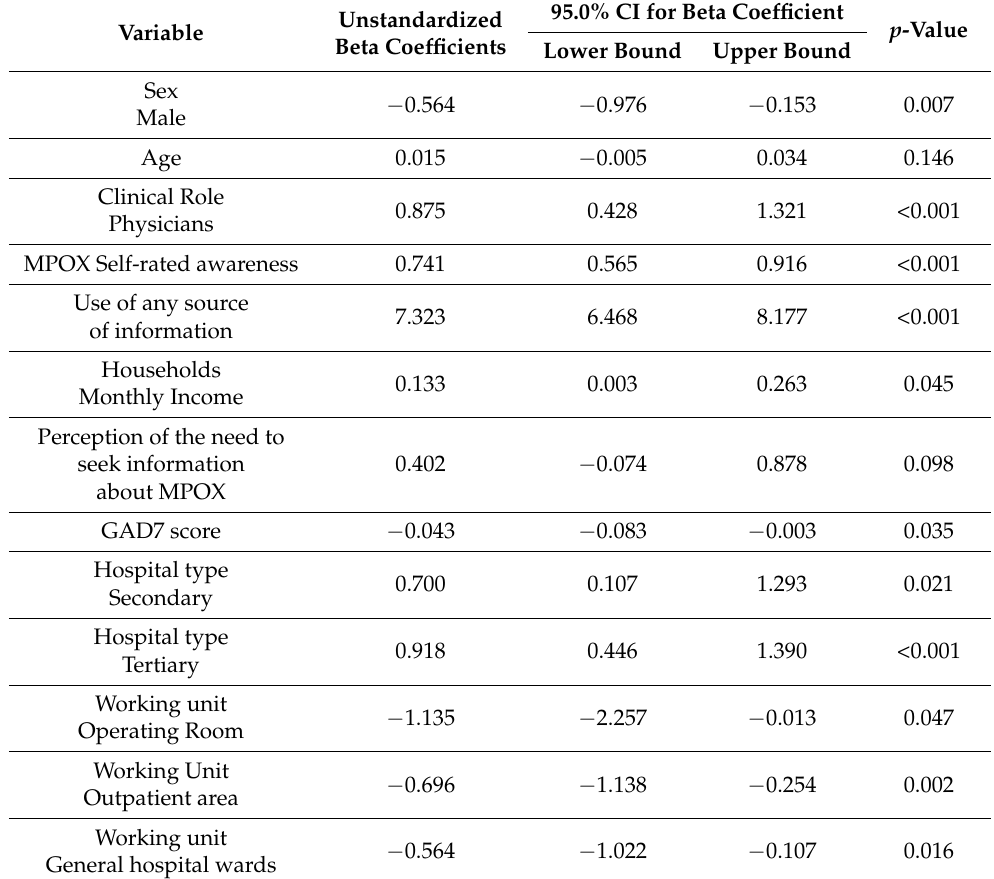
Table 4. Multivariate linear regression analysis of the HCWs’ variables associated with their mean overall MPOX knowledge score. (KSA, 27 May to 5 June